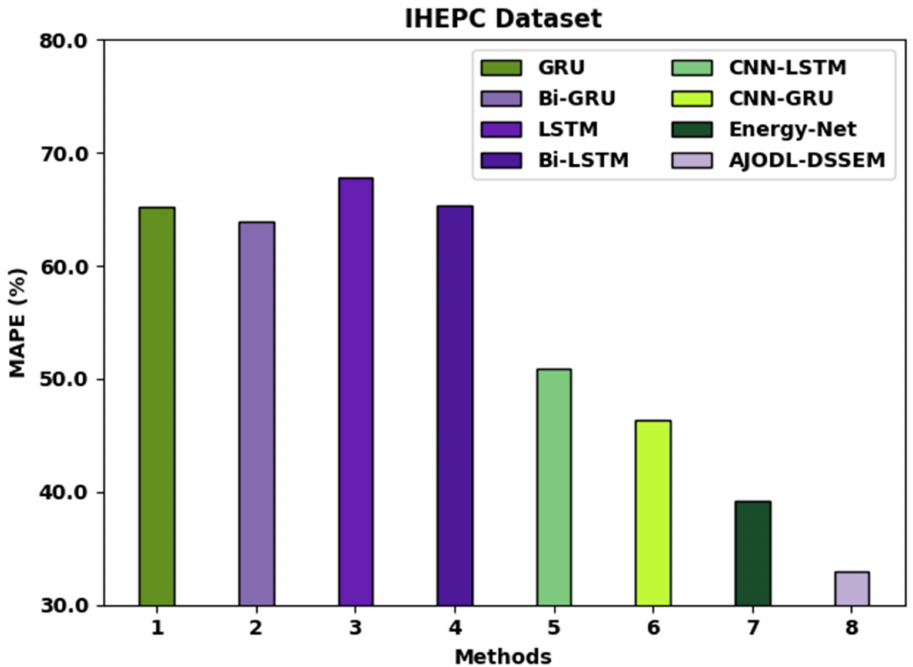
Figure 9. MAPE analysis of AJODL-DSSEM algorithm under IHEPC dataset.